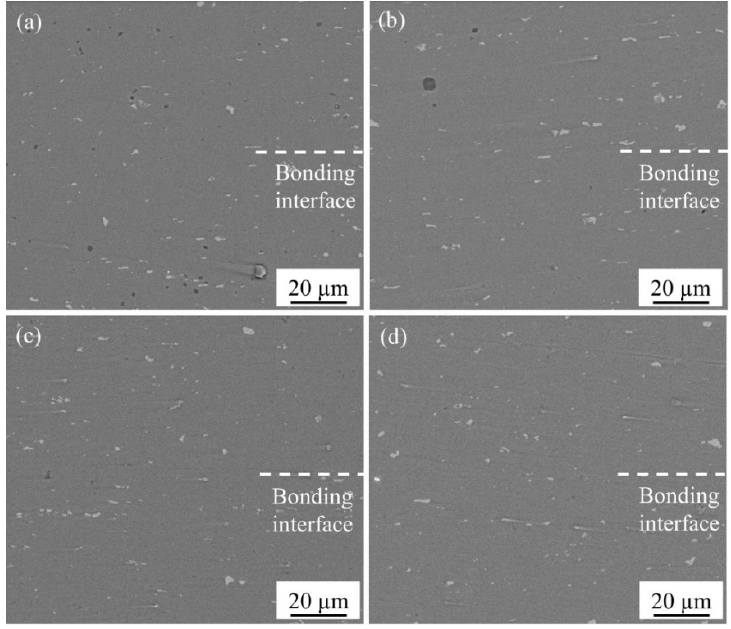
Figure 4. Microstructures of AA6061/AA6061 bonding interfaces after diffusion bonding at ( a ) 500 ◦ C, ( b ) 510 ◦ C, ( c ) 520 ◦ C, and ( d ) 530 ◦ C for 120